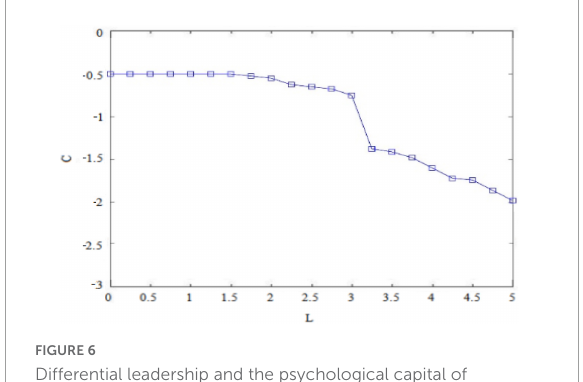
FIGURE6 Differential leadership and the psychological capital of “subordinates outside the circle.”